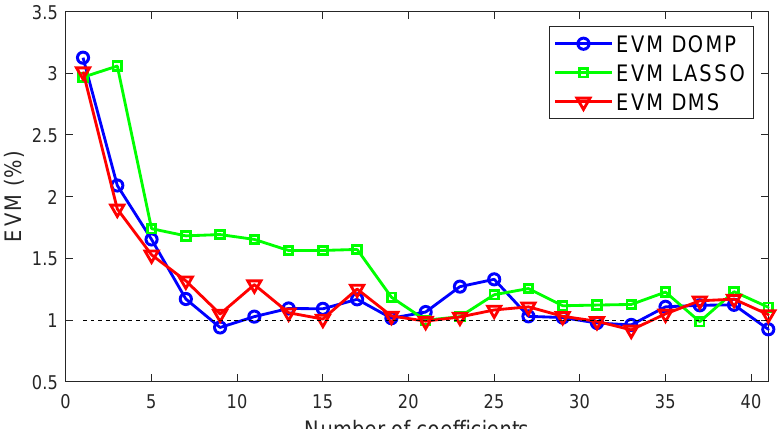
Figure 12. Worst EVM versus the number of coefficients when considering DOMP, DMS and LASSO feature selection